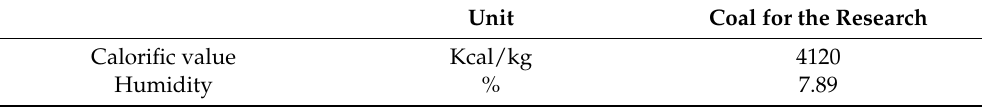
Table 8. Properties of